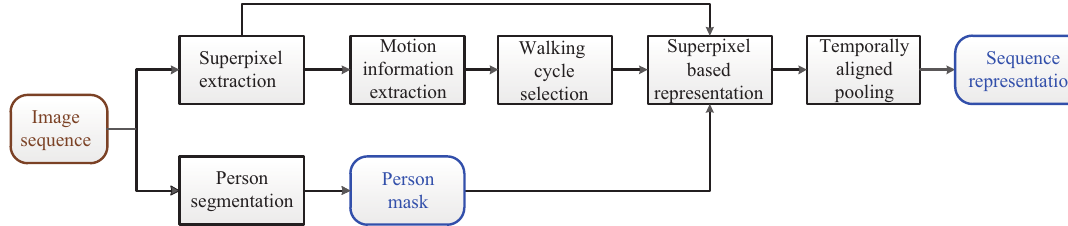
Figure 1. Framework of the proposed superpixel-based temporally aligned